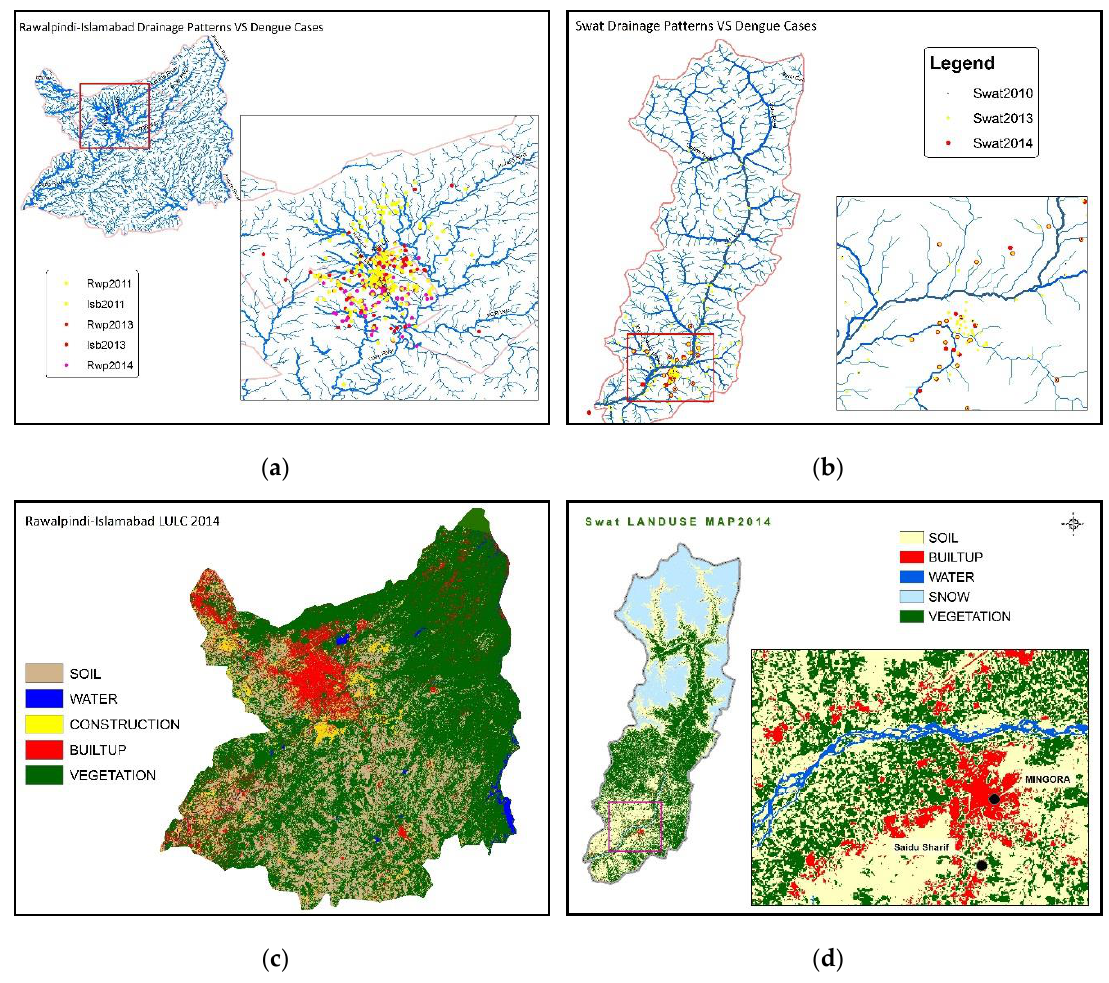
Figure 5. Dengue Cases Distribution and their relationship with Drainage patterns and Land-Use-Land-Cover (LULC) for Rawalpindi-Islamabad and Swat. ( a ) Drainage Pattern Rawalpindi-Islamabad vs . Dengue cases; ( b ) Drainage Pattern Swat vs . Dengue cases; ( c ) LULC Rawalpindi-Islamabad 2014; ( d ) LULC Swat 2014.